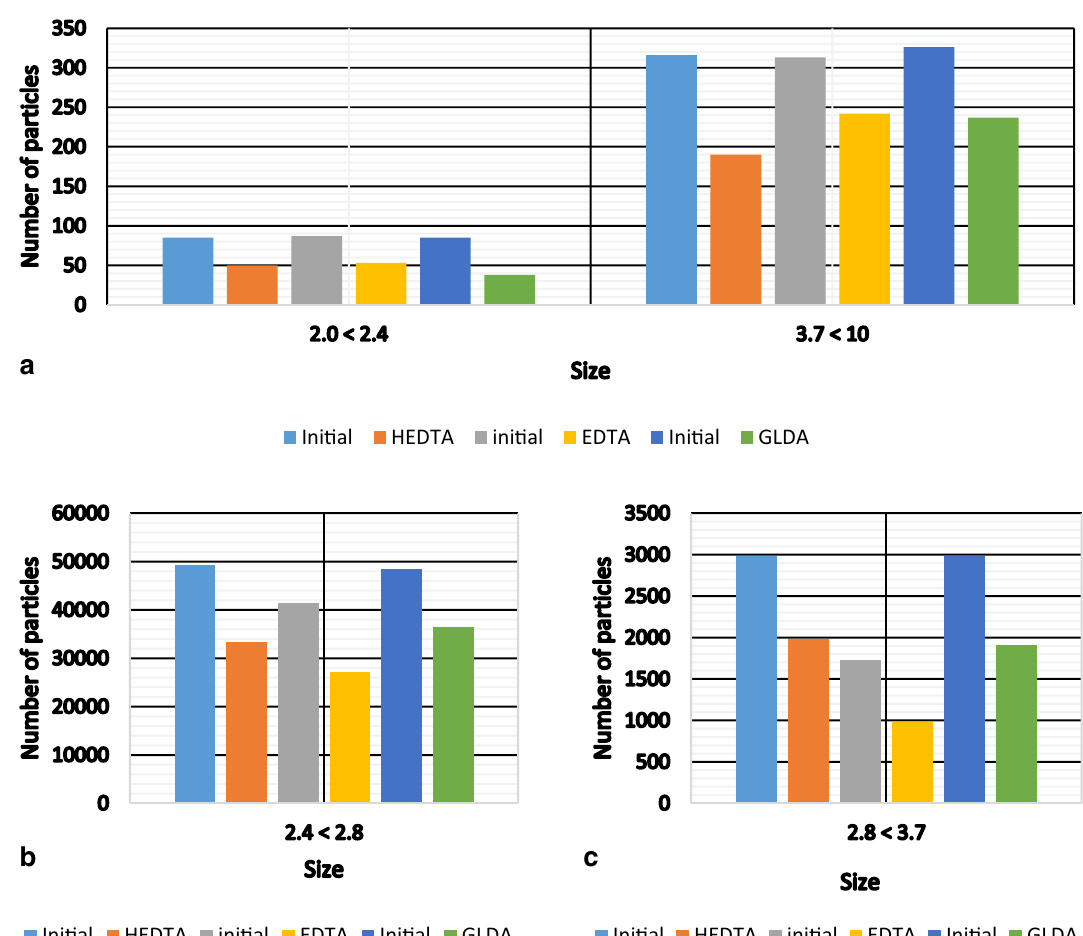
Fig. 19 Particles density distribution in Colton Sandstone before and after reaction with chelating